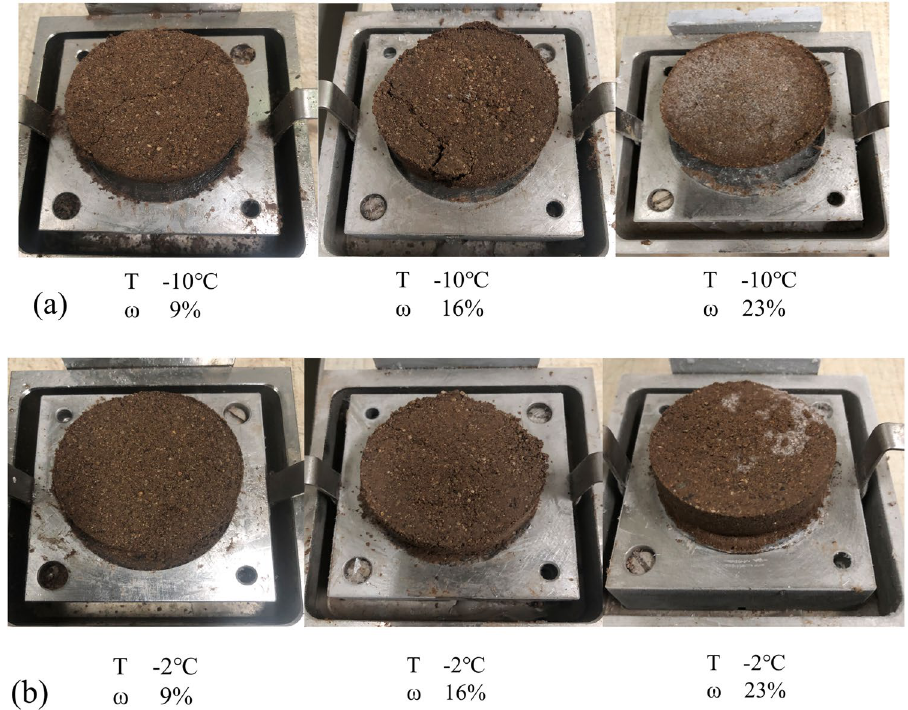
Figure 7. Morphology of specimens after shear failure at different moisture contents: ( a ) shear temperature of − 10 °C; ( b ) shear temperature of − 2